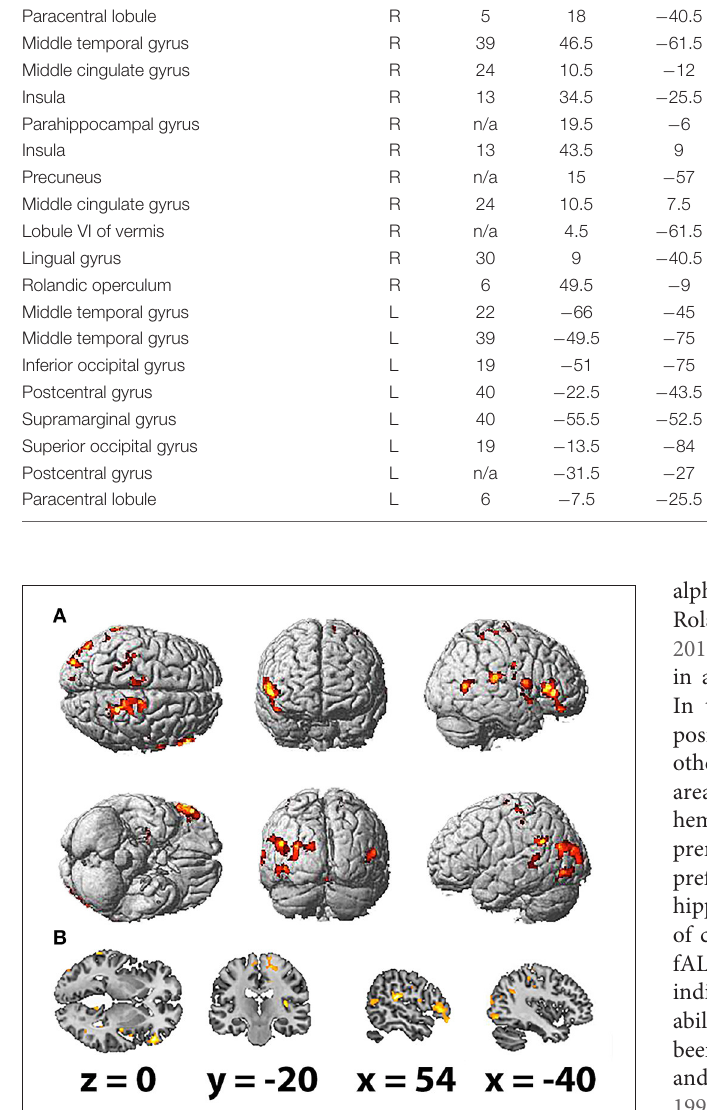
Middle cingulate gyrus